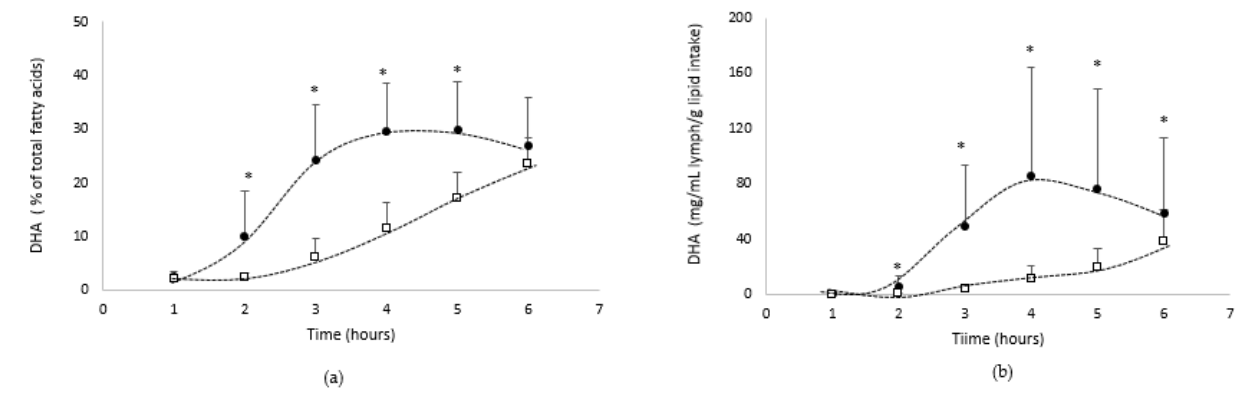
Figure 5. Kinetics of intestinal absorption of DHA (( a ): % of total fatty acids and ( b ): mg/mL lymph/g of lipid intake), in rats submitted to a lymphatic duct’s fistula ( n = 8 rats/group) and orally supplied with 200 mg of lipids from an oil either in bulk phase ( (cid:3) ) or emulsified with gum acacia ( • ) over a 6 h period. Data are presented as their means ± standard deviation *. For the same time period, data are significantly different between the two groups ( p < 0.05; Student’s t -test).